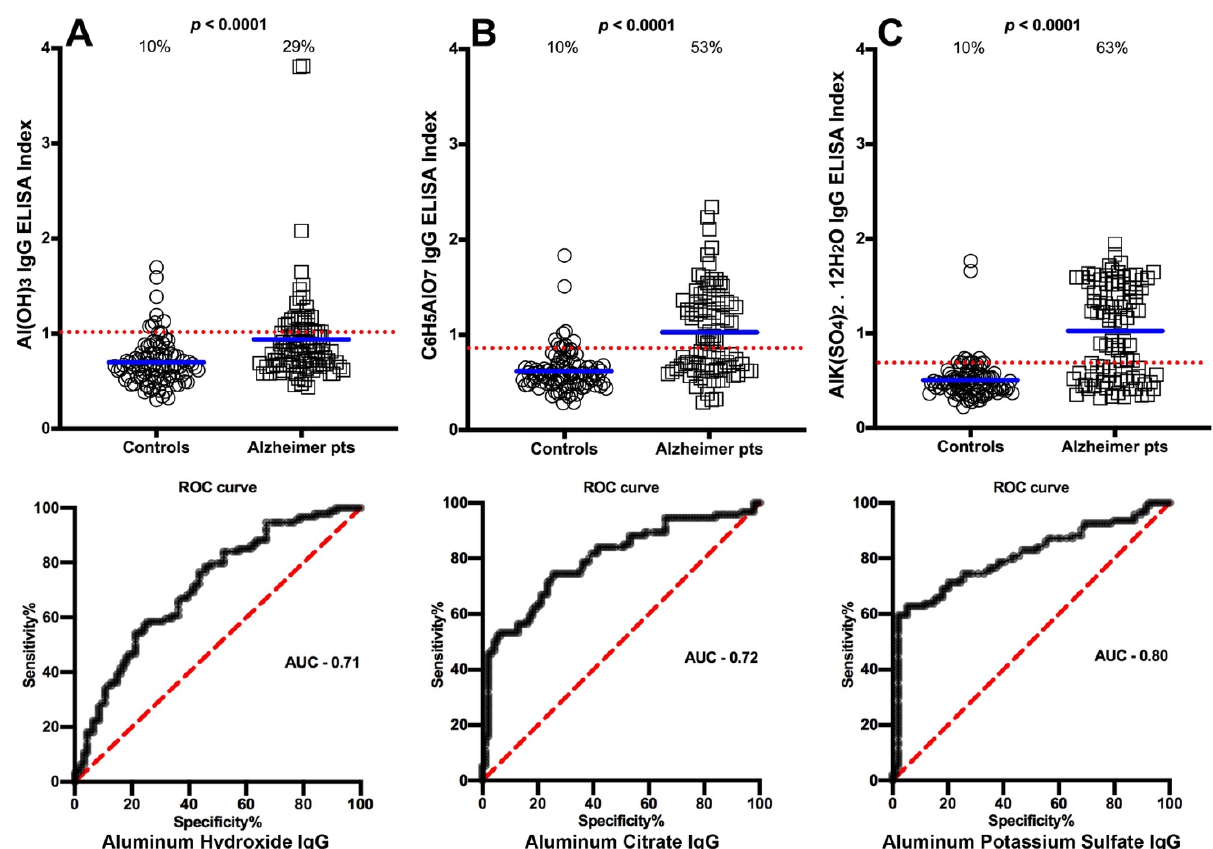
Figure 3. Percentages of samples with elevations in IgG antibodies against three different aluminum compounds in 94 healthy controls and 47 patients positive for Alzheimer’s disease. Dotted horizontal lines indicate the cutoff for positivity used in each assay, as calculated by receiver operating characteristic (ROC) analysis. The percentages of elevation, controls vs. patients, are indicated at the top of each distribution, while the thick short horizontal full bars indicate the respective means ( A ) The percentage of Alzheimer’s disease patients with elevated IgG antibodies against aluminum hydroxide was 29%, with an area under the curve (AUC) of 0.71; ( B ) The percentage of Alzheimer’s disease patients with elevated IgG antibodies against aluminum citrate was 53%, with an AUC of 0.72; ( C ) The percentage of Alzheimer’s disease patients with elevated IgG antibodies against aluminum potassium sulfate was 63%, with an AUC of 0.80.